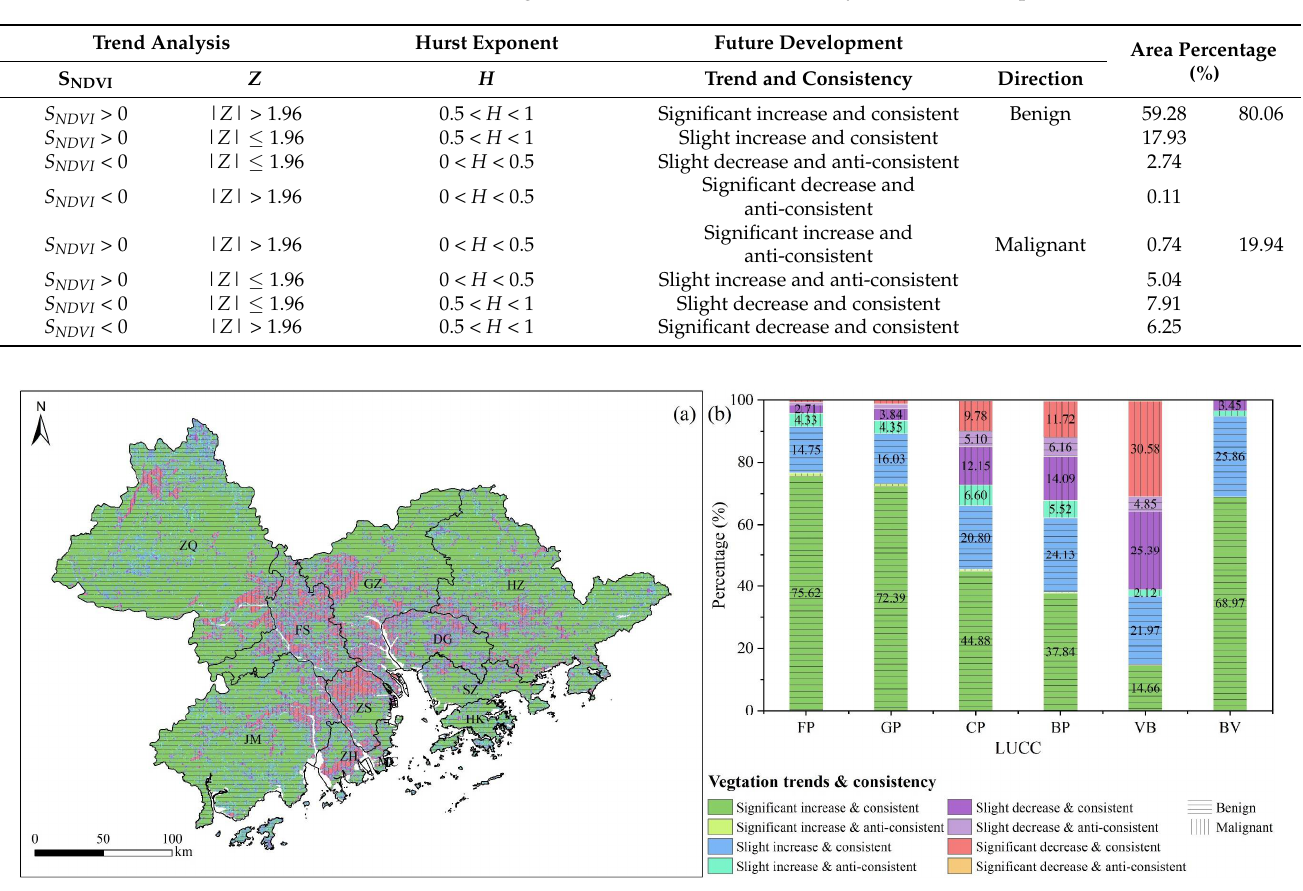
Table 3. Future changes in NDVI based on trend analysis and Hurst exponent.